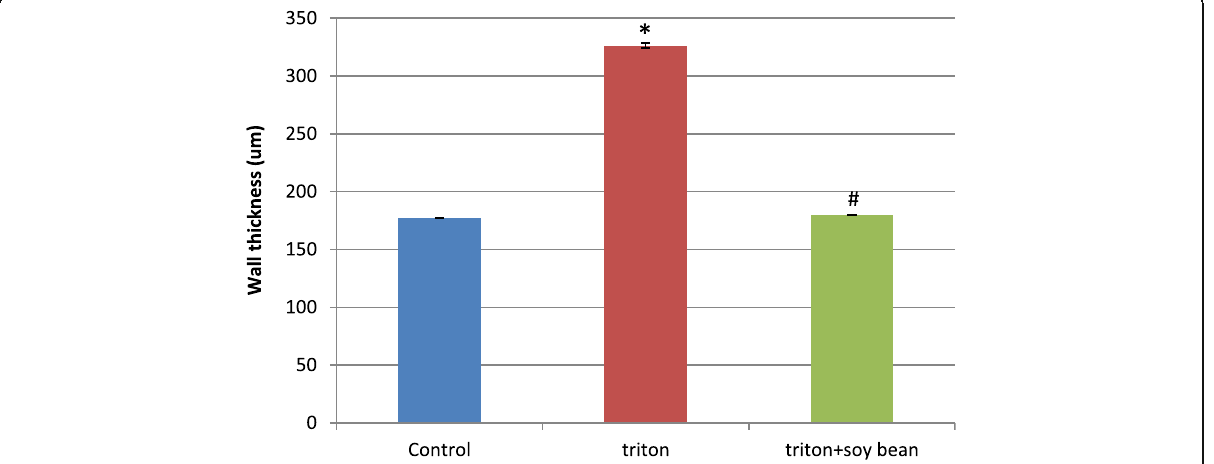
Fig. 3 Means of wall thickness of dorsal aorta of vehicle control, triton-treated rats, and triton + soybean-treated rats. Significant difference from the control group at * P < 0.05. Significant difference from the triton-intoxicated group at # P <